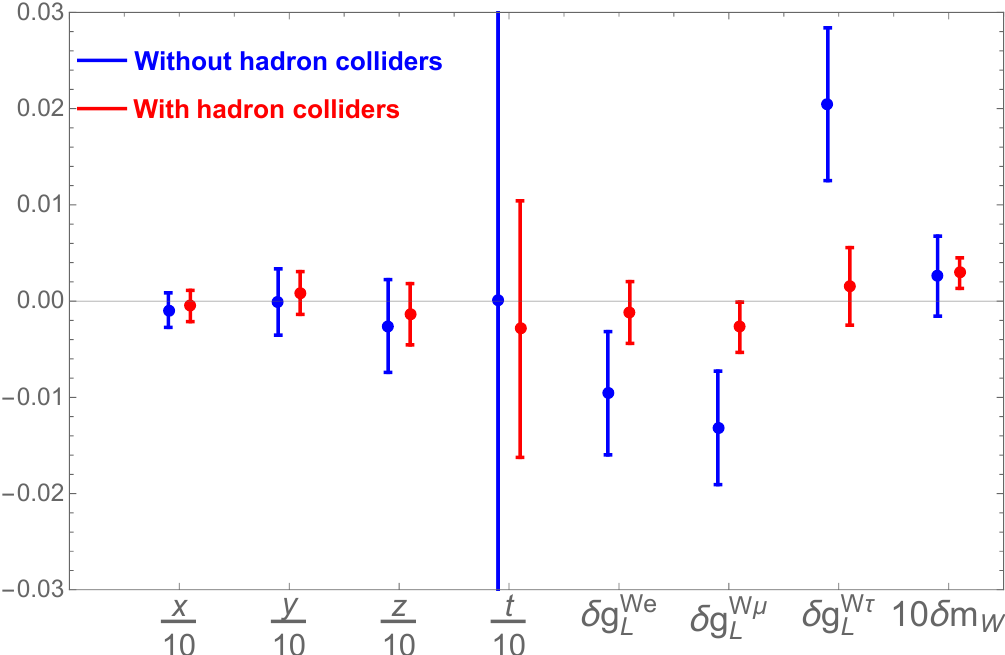
Figure 5 . Comparison of the marginalized constraints on selected parameters in the electroweak fit, with (red error bars) and without (blue error bars) using hadron collider observables. Here, x, y, z, t defined in eq. (3.9) are linear combinations of the non-SM corrections to the coupling between the Z boson and light quarks, δg W‘ are corrections to the coupling between the W boson and left-handed L leptons, and δm W is a correction to the W boson